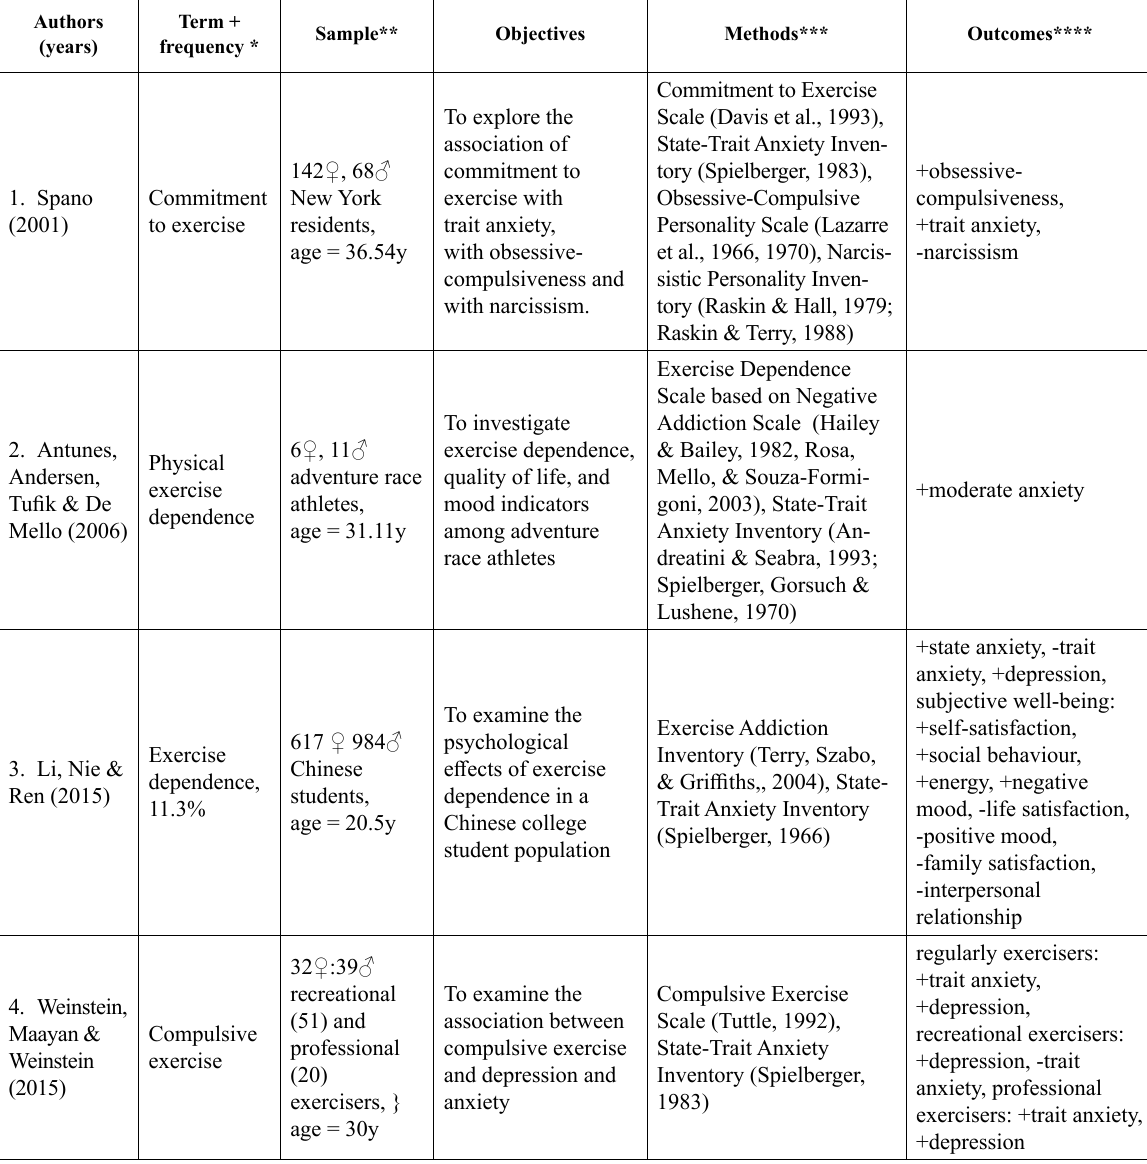
Table 6. Summary of studies between 1995 and 2016 investigating the relationship between exercise addiction and trait